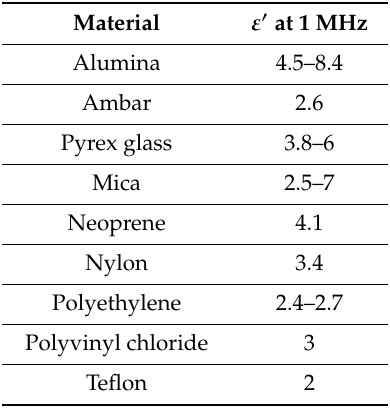
Table 1. Relative dielectric constant and tangent of delta of various materials used as a dielectric capacitor